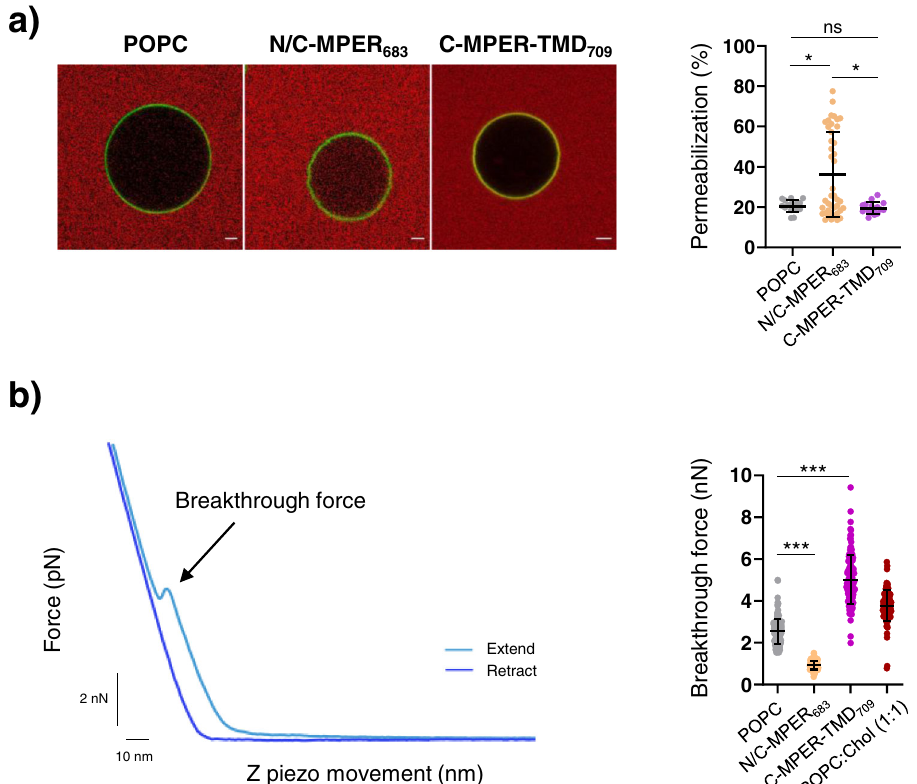
Fig. 6 Effects of C-MPER helix reconstitution on the stability of lipid bilayers. a Stability measured in single-vesicle assays. Left: Micrographs of NBD- labeled single GUVs immersed in a solution containing the water-soluble KK114 fl uorescent probe (red background). GUVs devoid of peptide are compared with those containing the N/C-MPER 683 or C-MPER-TMD 709 peptide reconstituted. The presence of red label inside the vesicles indicates effective permeabilization. Right: quantitation of permeabilization levels after 60 min incubation. Scale bars are 2 µ m. Number of vesicles n ≥ 16. Center line, mean; whiskers SD (Mann – Whitney Test: *** p < 0.001; ** p < 0.01, * p < 0.05, n.s. ≥ 0.05). b Effects on the breakthrough force of POPC SPBs. Left: Experimentally measured approaching and retraction force curves performed on a sample showing the jump in distance of ca. 4 nm with an applied force of 6 nN. Right: Mean breakthrough force values measured in the different samples. The N/C-MPER 683 -containing SPBs displayed signi fi cantly lower breakthrough forces than those containing C-MPER-TMD 709 . Number of measurements n ≥ 200. Center line, mean; whiskers SD (Mann – Whitney Test: *** p < 0.001; ** p < 0.01, * p < 0.05, n.s. ≥ 0.05). The peptide-to-lipid mole ratio was 1:50 in the samples containing peptide. The POPC:Chol (1:1) sample was included